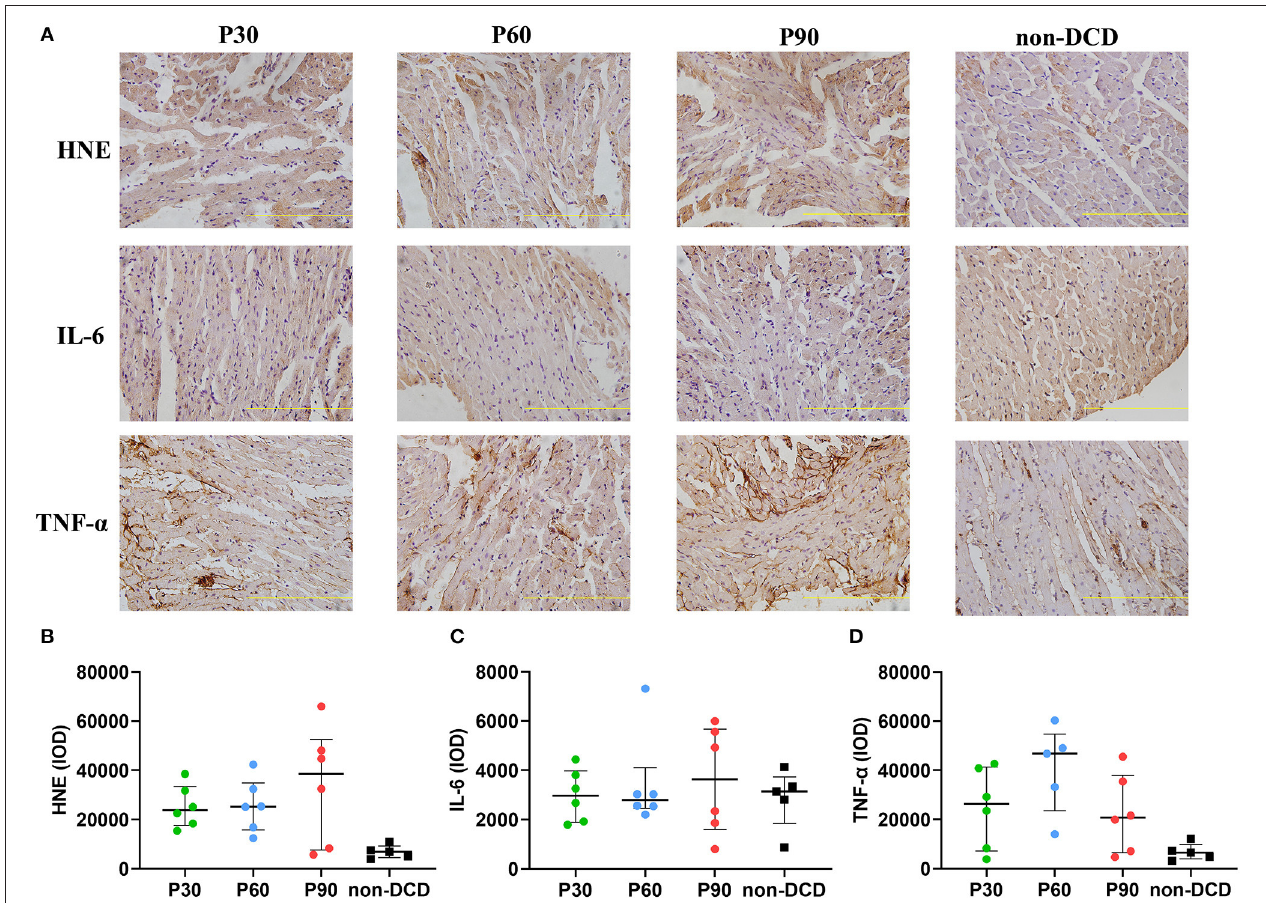
FIGURE 5 | The expression of HNE, IL-6, and TNF- α in the donor heart during ESHP. (A) Representative photomicrographs of Immunohistochemistry for donor hearts. Bar scale: 100 µ m; (B) Mean HNE IOD. n = 6 for P30, P60, and P90 group, n = 5 for non-DCD group; (C) Mean IL-6 IOD. n = 6 for P30, P60, and P90 groups, n = 5 for non-DCD group; (D) Mean TNF- α IOD. n = 6 for P30 and P90 groups; n = 5 for P60 group and non-DCD group. Data represented as median and interquartile range. DCD, Donation after circulatory death; ESHP, Ex situ heart perfusion; HNE, 4-Hydroxynonenal; IL-6, Interleukin-6; IOD, Integrated optical density; TNF- α , Tumor necrosis factor- α